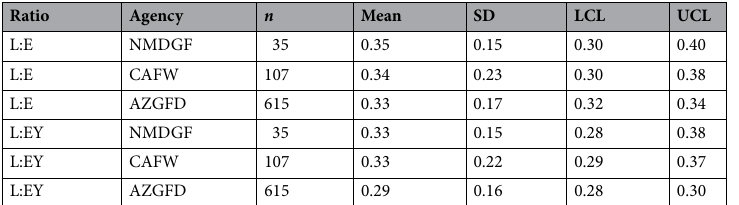
Table 1. Recruitment data from desert bighorn sheep populations during years with adult female (ewe) abundance ≥ 20. The ratios labeled L:E represent the mean lamb:ewe ratio with yearling counts excluded from the denominator, and L:EY represents the mean lamb:ewe ratio with yearling counts included in the denominator (90% CIs; LCL—Lower, UCL—Upper, SD indicates standard deviation). The column “ n ” reports the number of site-years included in the calculation. Acronyms are as follows: AZGFD Arizona Game and Fish Department, CAFW California Department of Fish and Wildlife, NMDGF New Mexico Department of Game and